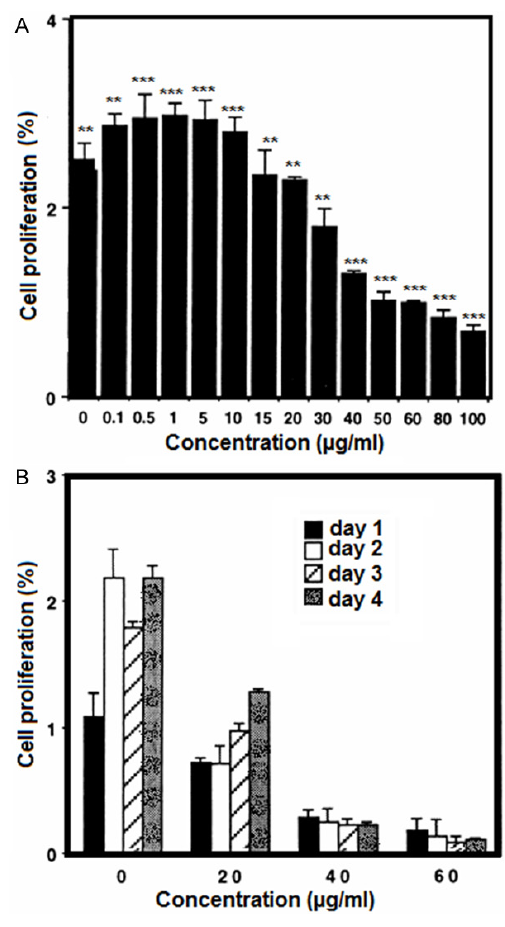
Figure 2. Effects of glycitein on the proliferation of SKBR-3 cells. (A) SKBR-3 cells were treated with glycitein for 2 days at the concentrations indicated or (B) for 0 to 4 days at preestablished concentra- tions. The values with ** and ***indicate significant difference ( P < 0.005) and very significant differ- ence ( P < 0.0001), respectively, compared with the dimethylsulfoxide-treated cells (0 mg/mL of glycitein) as